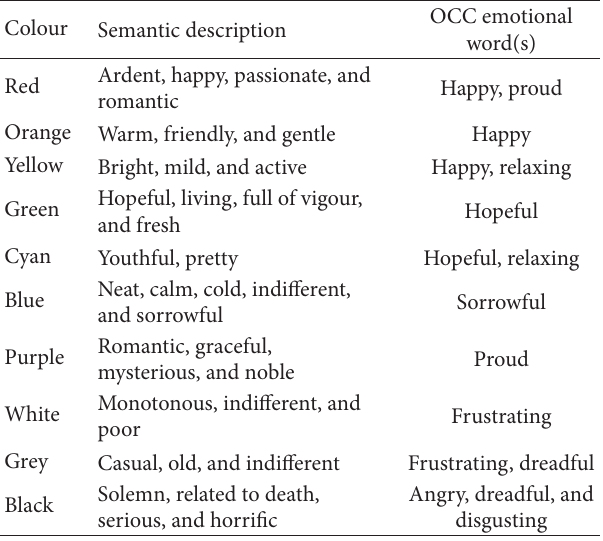
Table 1: A comparison of colour and emotion